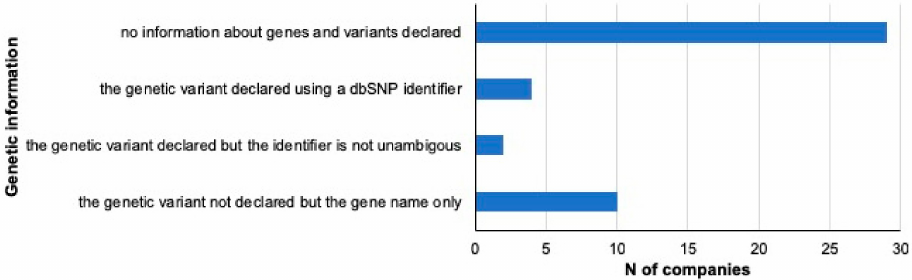
Figure 2. Characterization of the selected DTC-GT companies based on the genetic information provided. In the graph, the selected DTC-GT companies are classified based on the type of information on genes and variants analyzed that is provided to the consumer. N =